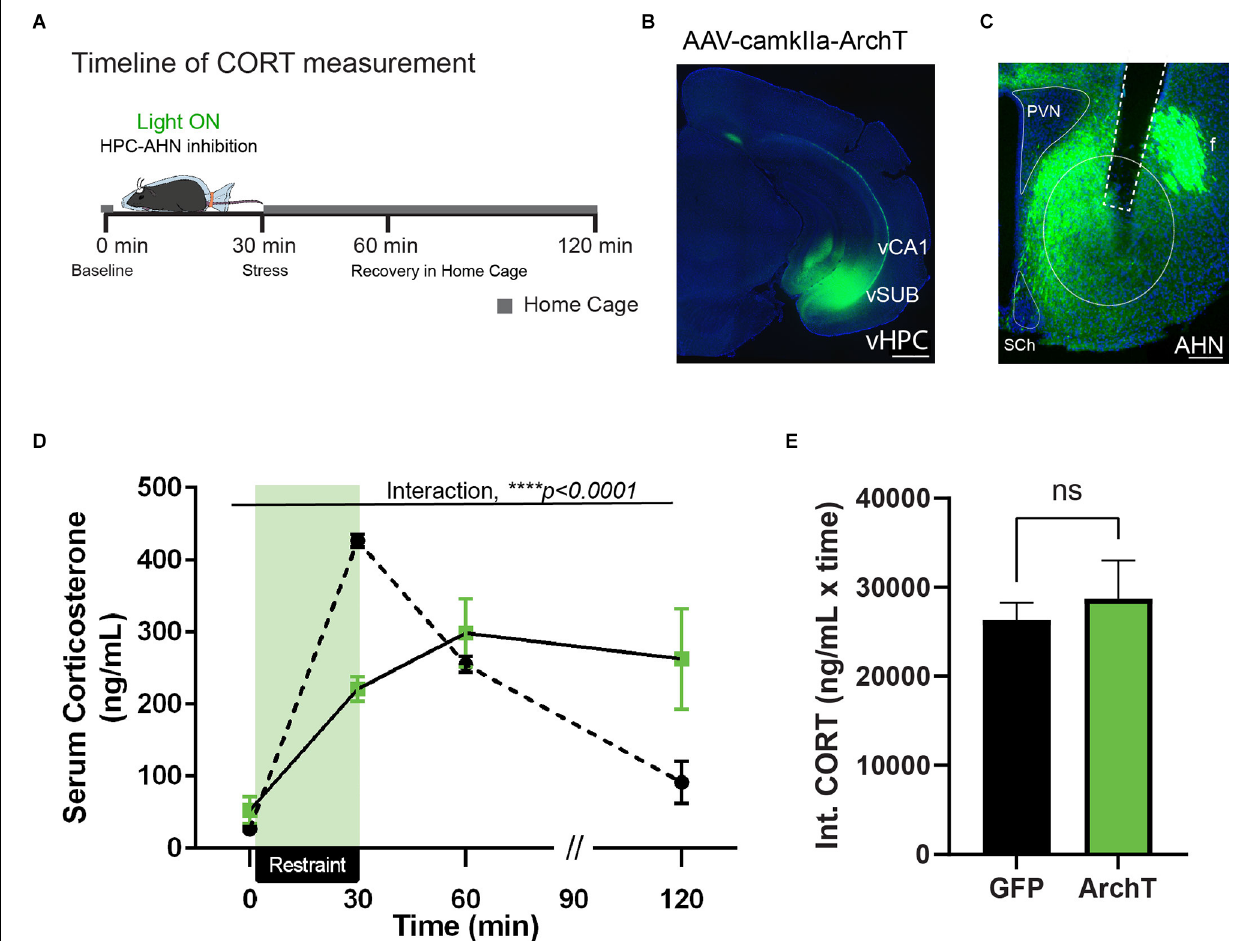
FIGURE 2 | HPC → AHN is necessary for negative feedback of HPA-axis. (A) A cartoon schematic of serum CORT measurement relative to physical restraint induced stress. (B) A representative image of ventral hippocampus with AAV-camkII-ArchT-GFP transfection. The ventral portion of the temporal hippocampus. vCA1, ventral cornuammonis 1; vSUB, ventral subiculum. Scale bar = 500 µ m. Green, ArchT expression. (C) Ventral hippocampal terminals labeled in GFP densely innervate the anterior hypothalamus (AHN), and do not innervate the paraventricular nucleus (PVN). Sch, suprachiasmatic nucleus. Scale bar = 100 µ m. (D) HPC → AHN inhibition during physical restraint stress decreased peak corticosterone release and impaired negative feedback of the HPA-axis (GFP N = 5, ArchT N = 7, 2-WAY RM ANOVA, time × rhodopsin, F (3,30) = 11.43, **** p < 0.0001, time effect, F (1.499,14.99) = 30.29, **** p < 0.0001, rhodopsin effect, F (1,10) = 0.0188, p = 0.8937, NS, Bonferroni’s multiple comparisons test, t = 0 GFP vs. ArchT, p > 0.9999, t = 30 GFP vs. ArchT, **** p < 0.0001, t = 60 GFP vs. ArchT, p > 0.9999, t = 120 GFP vs. ArchT, p = 0.2617, NS, Bonferroni’s multiple comparisons test across time, GFP t = 0 vs. t = 30, *** p < 0.0001, GFP t = 0 vs. t = 60, *** p = 0.0008, t = 0 vs. t = 120, p = 0.8184, NS, t = 30 vs. 60, ** p = 0.004, t = 30 vs. t = 120, ** p = 0.0053, t = 60 vs. t = 120, * p = 0.0343, ArchT t = 0 vs. t = 30, ** p = 0.0014, t = 0 vs. t = 60, * p = 0.0151, t = 0 vs. 120, p = 0.0994, NS, t = 30 vs. t = 60, p > 0.9999, NS, t = 30 vs t = 120, p > 0.9999, NS, t = 60 vs. 120, p > 0.9999). (E) Integrated CORT (Int. CORT) reported comparable total circulating CORT concentration between GFP and ArchT mice during stress-induced HPA-axis (unpaired t -test, t = 0.1606, df = 10, p = 0.8756, NS). All results reported are mean ± s.e.m. * p < 0.05, ** p < 0.01, *** p < 0.001, **** p <